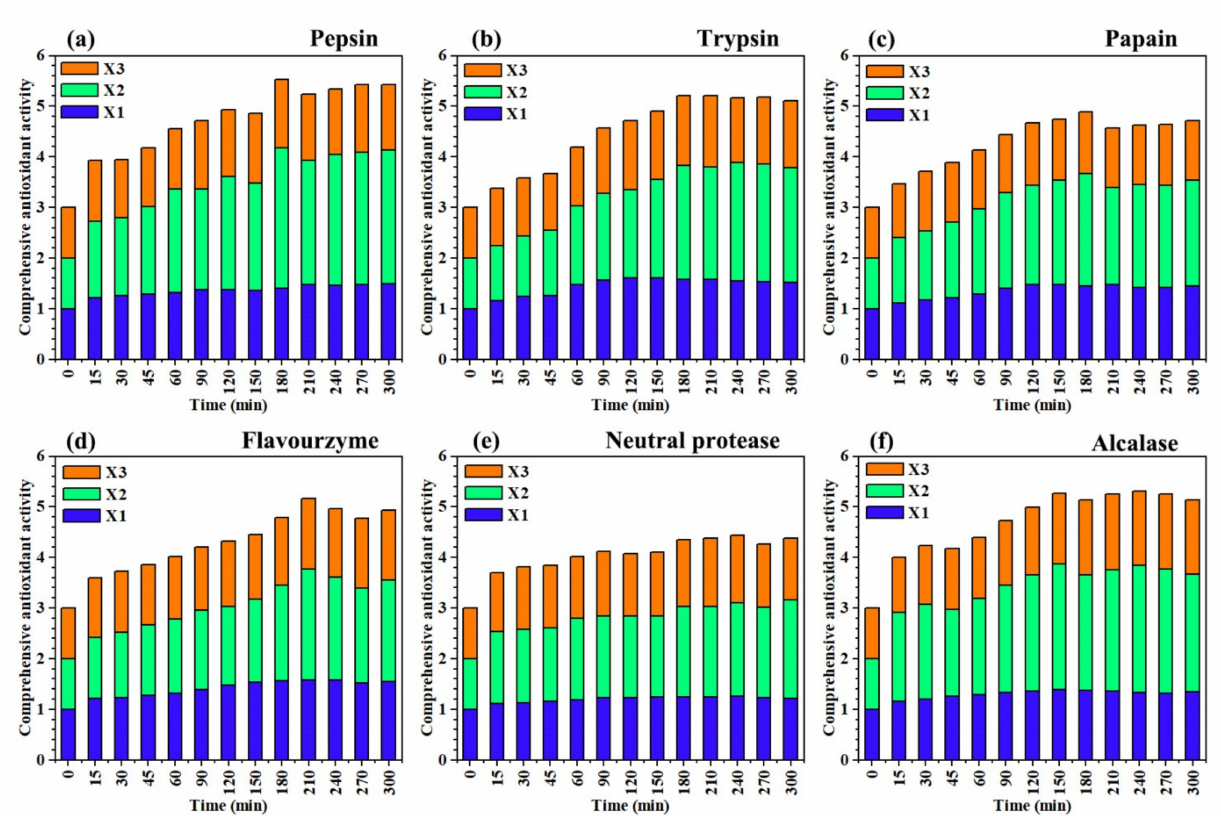
Figure 4. Comprehensive antioxidant activity of enzymatic hydrolysates of different proteases at different times. The experimental data in the figure are the average values of three parallel determinations. ( a – f ) The corresponding proteases were pepsin, trypsin, papain, flavourzyme, neutral protease and alcalase. X1: the relative value of DPPH radical scavenging activity, X2: the relative value of reducing power, X3: the relative value of hydroxyl radical scavenging